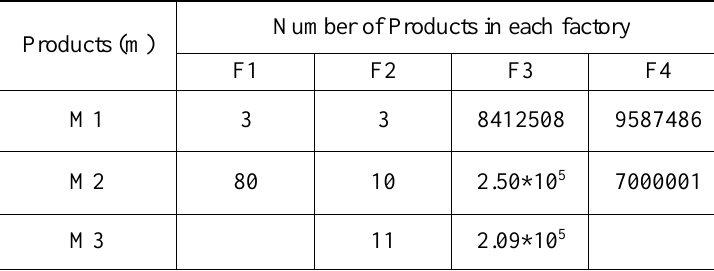
Table 9- Amounts of end product which factory sends to each of costumer